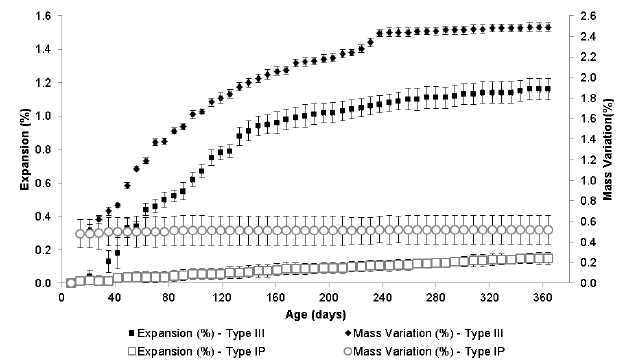
Figure 7. Expansion and mass variation of concretes over time.